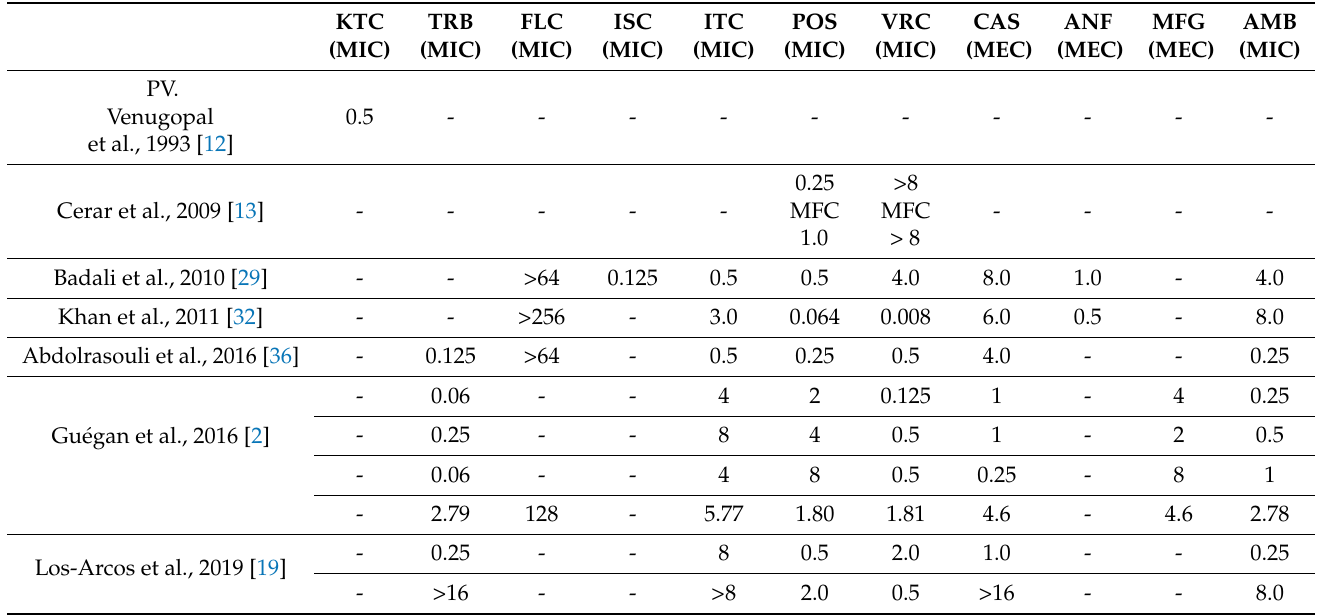
Table 4. Minimum inhibitory concentrations (MIC) or effective concentrations (MEC) of M. romeroi in mg/L for different antifungals